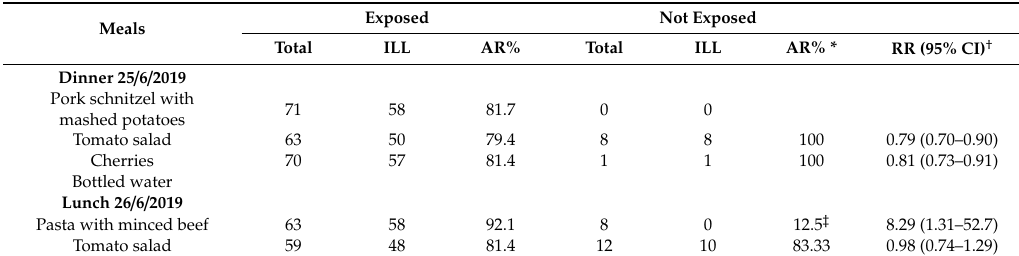
Table 1. Results of the univariable analysis of the consumption of common meals, among the four teams, cohort study, Panhellenic Athletic Championship of Handball for Children, Greece, June